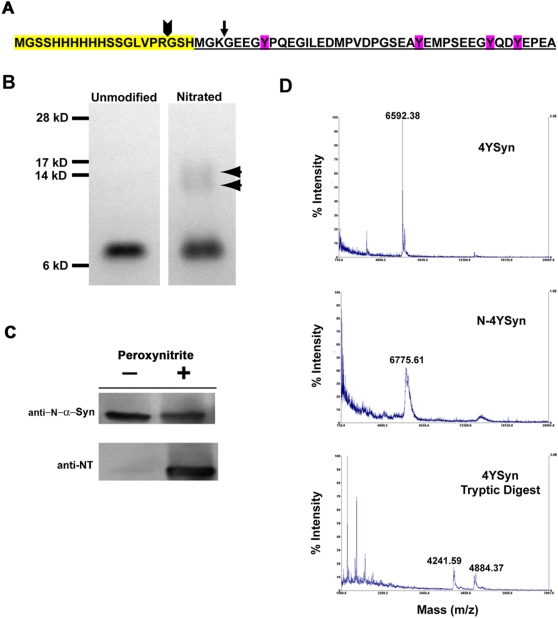
Characterization of purified and nitrated recombinant 4YSyn.(A) Primary aa sequence of His-tagged 4YSyn peptide. The His-Tag sequence is highlighted in yellow. The sequence of 4YSyn (Syn100–140) is shown underlined with 4 Tyr residues (magenta) as potent sites for nitration. Trypsin cleavage sites at Arg (arrowhead) and Lys (arrow) are shown. (B) Purified 4YSyn (lane 1) and N-4YSyn following nitration with peroxynitrite (lane 2) fractionated on a 10–20% polyacrylamide gel and visualized using silver stain. Covalently cross-linked oligomers are indicated by arrowheads. (C) Western blot confirmation of purified 4YSyn and its associated NT modifications following peroxynitrite treatment. (D) MALDI-TOF spectra of purified 4YSyn (top panel), N-4YSyn (middle panel), and 4YSyn after tryptic digest (lower panel).